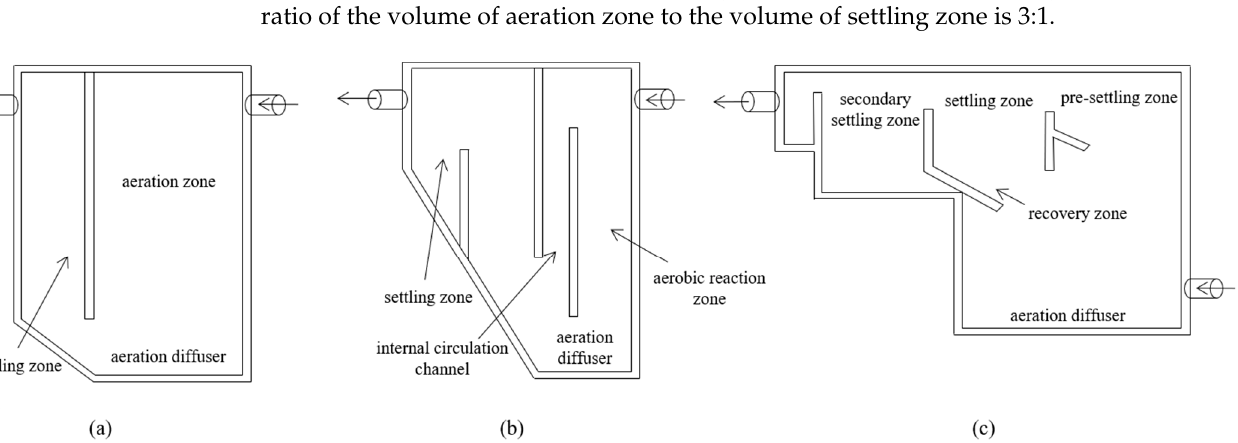
Figure 1. Geometry of three CFRs: R1 ( a ), R2 ( b ) and R3 ( c ).